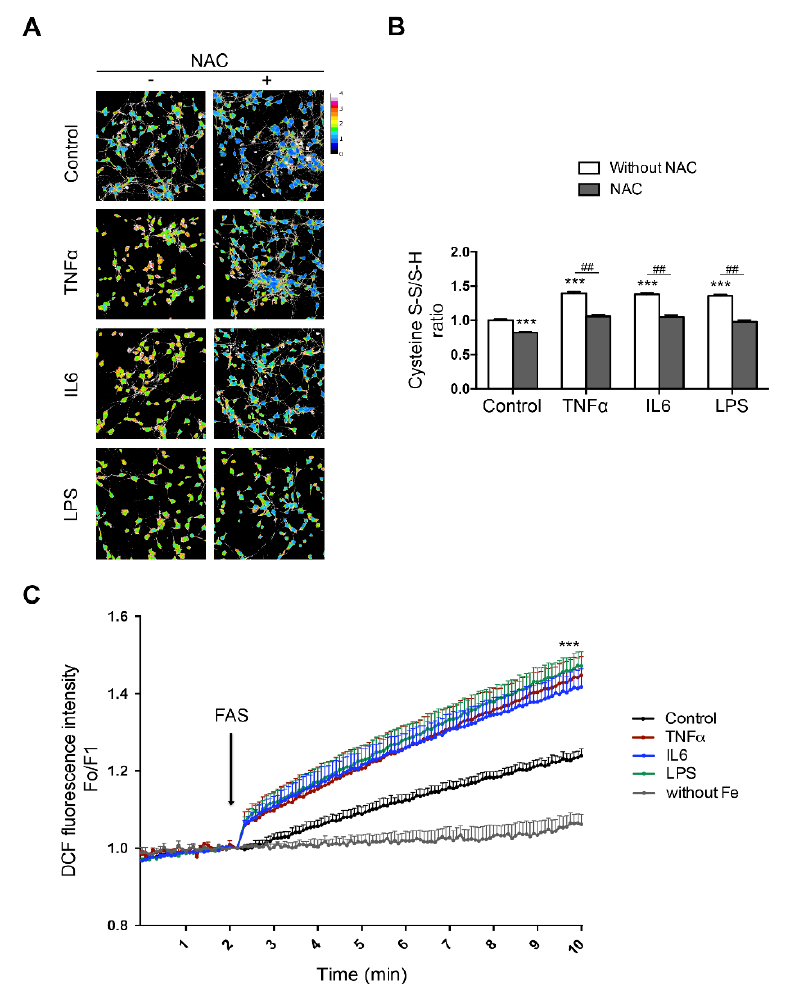
Figure 3. Pro-inflammatory cytokines enhance iron-mediated reactive oxygen species (ROS) produc- tion. Hippocampal neurons (7 DIV) were treated with tumor necrosis factor (TNF) α (50 ng/mL), IL6 (50 ng/mL), or lipopolysaccharide (LPS) (1 µ g/mL) for 18 h in the presence or absence of 0.5 mM N-acetylcysteine (NAC). ( A ) The oxidative tone was evaluated by the amount of reduced and oxi- dized cysteine in proteins. Maleimide-Alexa 488 (green) was used to detect reduced cysteines and maleimide-Alexa 568 (red) to detect oxidized cysteines. The ratio between red and green fluorescence was transformed (ImageJ program) into a thermal scale (right hand bar) in which a shift from blue to red to white implies a higher degree of oxidation. ( B ) Quantification of the reduced/oxidized cysteine ratio. ( C ) Increased dichlorofluorescein (DCF) fluorescence, which is a dye sensitive to ROS production, was evaluated after the addition of ferric ammonium sulfate (FAS). Fluorescence data were collected in a microfluorometer plate reader and the ratio between fluorescence (F) and initial fluorescence (F o ) was plotted. Values represent the mean ± SEM ( n = 120 neurons, from three independent experiments). *** p < 0.001 compared to the control and ## p < 0.01 compared with the conditions without or with NAC. For protocol detail see